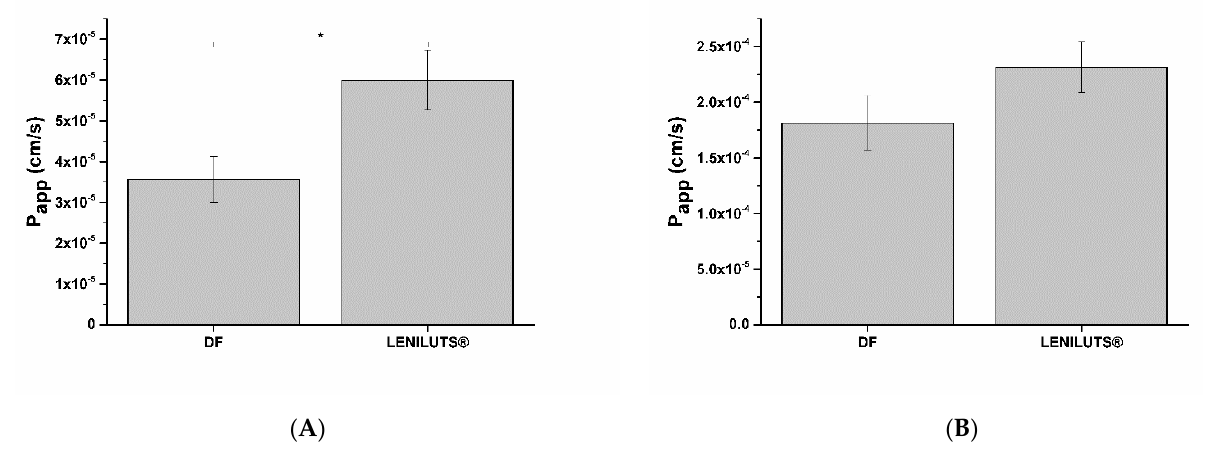
Figure 7. Apparent permeability (Papp) of intestinal epithelium exposed to digestive fluids (DF; control) and diluted digested formulation for 1 ( A ) and 3 h ( B ). * p < 0.05. As expected from its limited effect on the intestinal epithelium apparent permeability, digested LENILUTS ® only reduced TEER (trans-epithelial electrical potential) temporarily, and its values recover fully within 24 h (Figure 8).